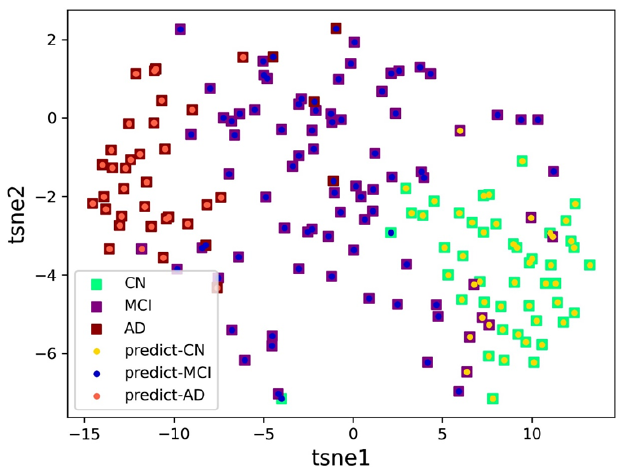
Figure 4. The two-dimensional t-SNE plot of the prediction results of DSSL for the test set samples.